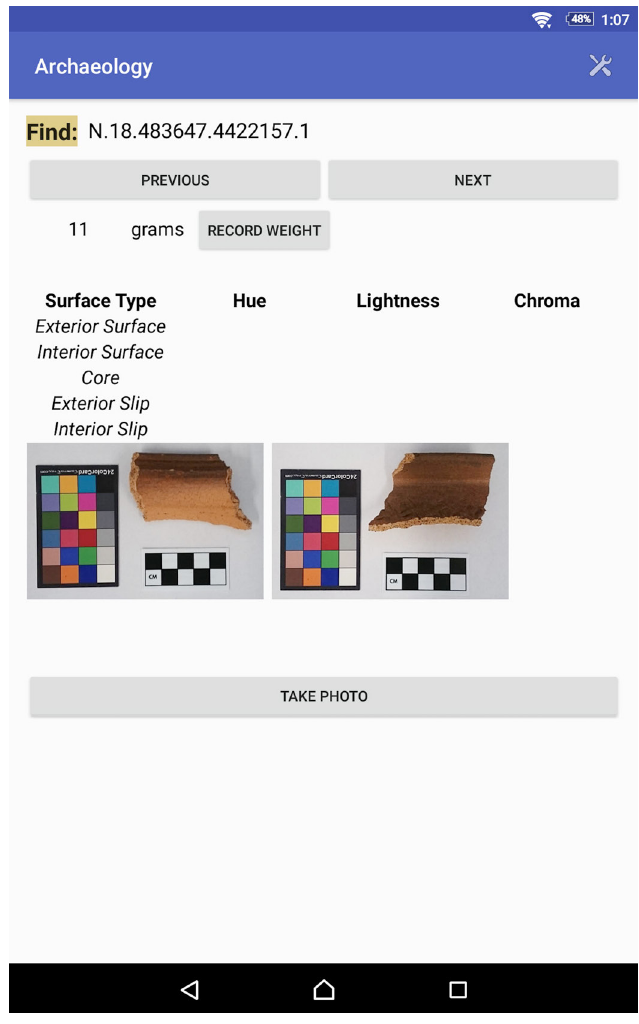
Figure 3. Screen capture of the object photography app data